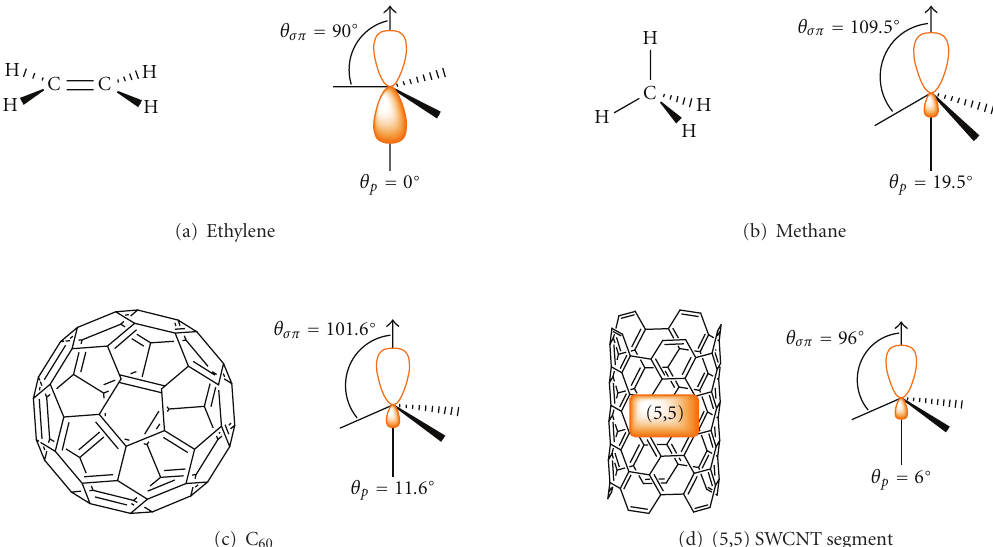
Figure 2: π -orbital axis vector analysis of curved π -conjugation in (a) ethylene, (b) methane, (c) C 60 , and (d) (5,5) SWCNT [45].